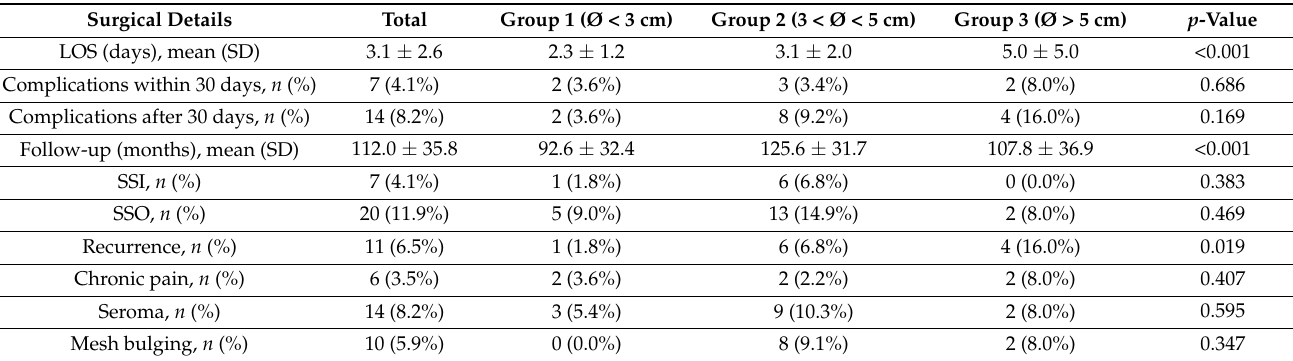
Table 5. Postoperative outcomes and long-term